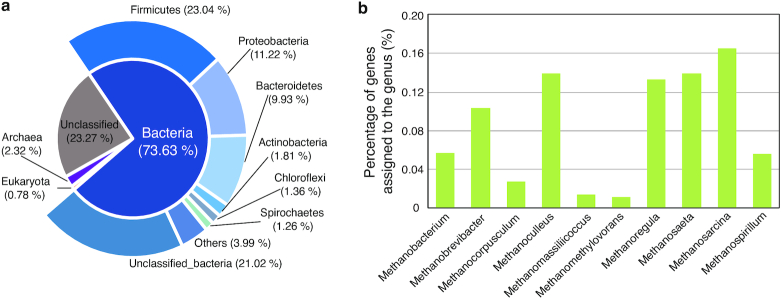
Taxonomic annotation of the microbial gene catalog of anaerobic digestion (MGCA). a, Taxonomic annotation of the gene catalog at the superkingdom and phylum levels. A total of 73.63% and 2.32% of genes in the gene catalog were assigned to Bacteria and Archaea, respectively. b, Percentage of genes assigned to the top 10 methanogenic archaea at genus level.